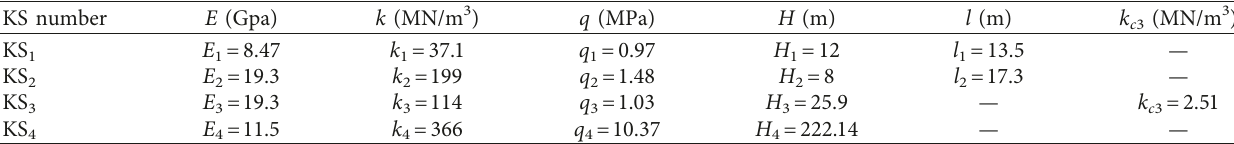
Table 1: KS parameters.